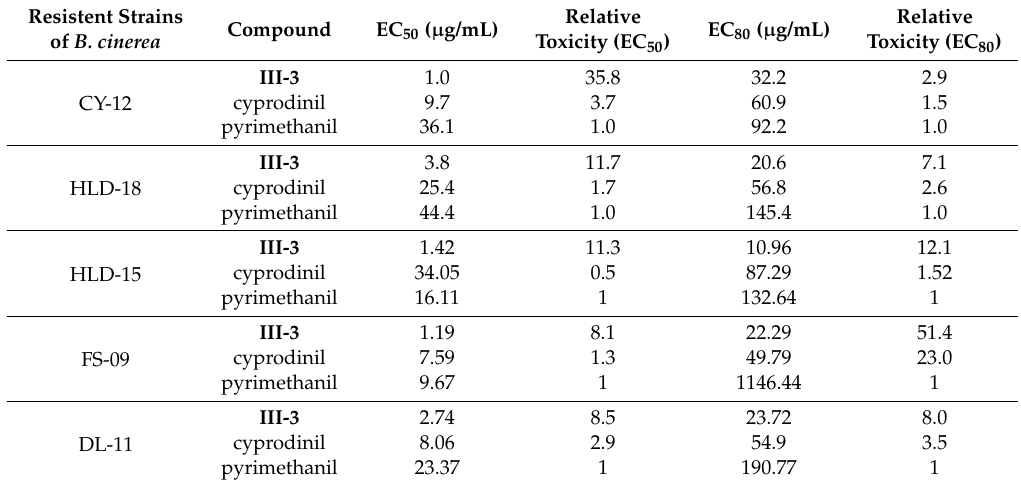
Table 3. The fungicidal activity of compound III-3 against resistent strains of B. cinerea (FGA). Resistent Strains of